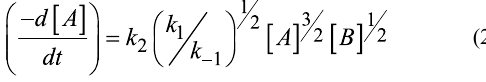
and the reaction time was obtained with high correlation factor (R 2 =